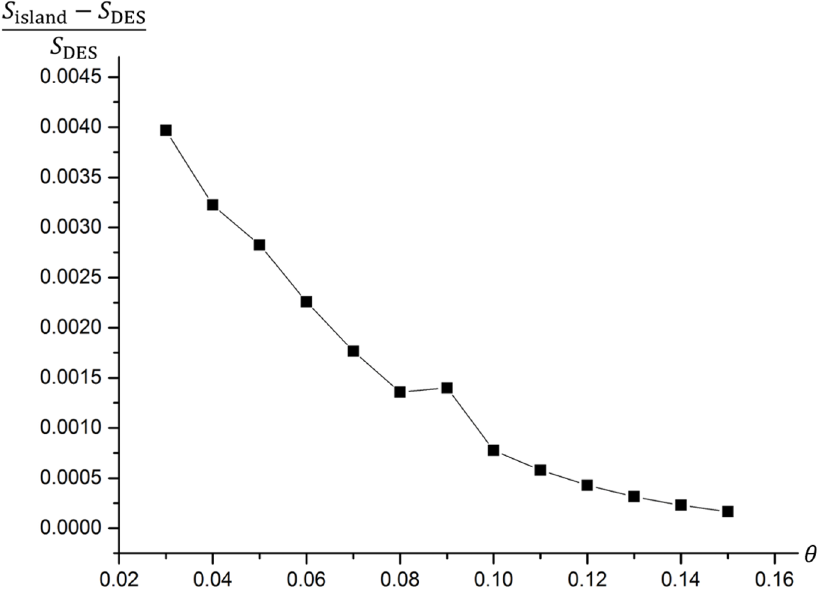
Figure 13 . Entropy difference divided by S DES with respect to θ